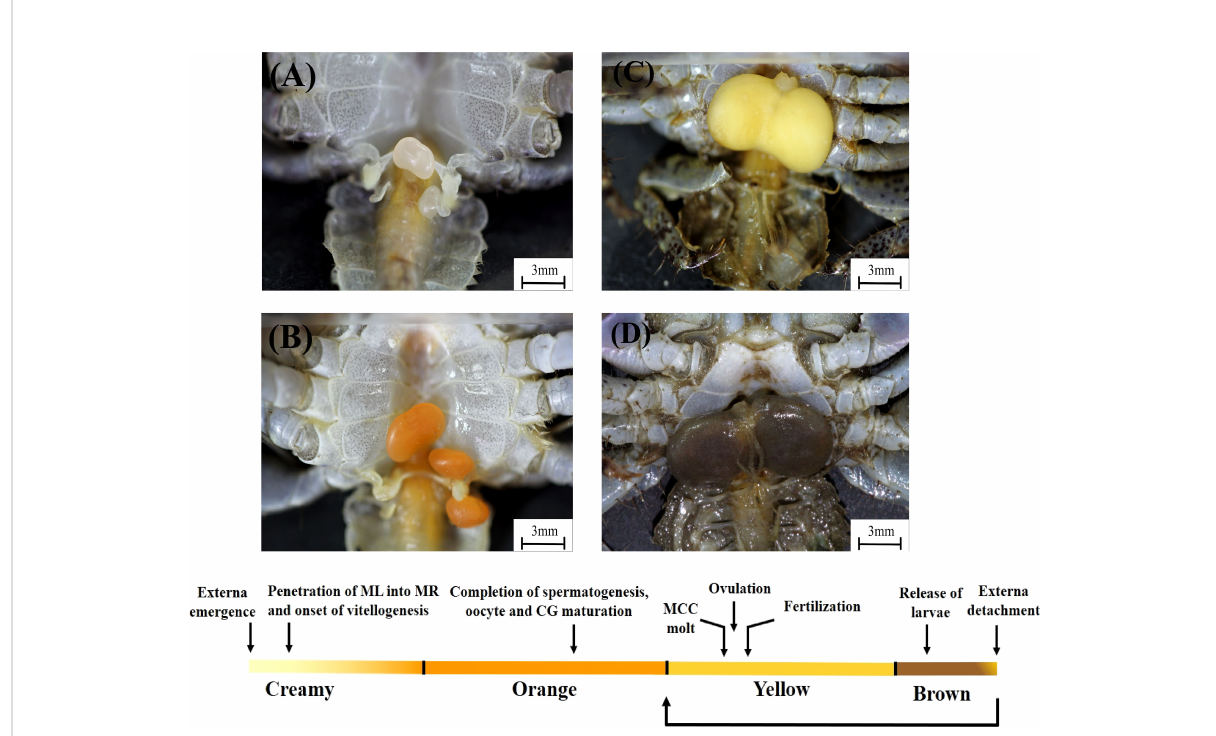
FIGURE 1 Development of the externa of Polyascus planus parasitizing the thukuhar shore-crab ( Metopograpsus thukuhar ). Upper: Development of the externa, which emerges on the ventral side of the host abdomen, is accompanied by distinct changes in the coloration of the externa, from creamy (A) , orange (B) , yellow (C) , to brown (D) . Lower: Development of the externa is divided into 4 stages, the Creamy, Orange, Yellow, and Brown, based on the color of the tissue, allowing determination of its developmental status based on an external trait. Developmental milestones (arrows) are given, with a caveat that they are intended to show the temporal order of the developmental events, but not meant to show that the events occur precisely at the time point indicated. Note that, after the release of larvae, brown externae could return to stage Yellow or become detached from the host. See text and Figures 2 – 5 for detailed descriptions of the development. CG, colleteric gland; ML, male larva; MCC, mantle cavity cuticle; MR, male